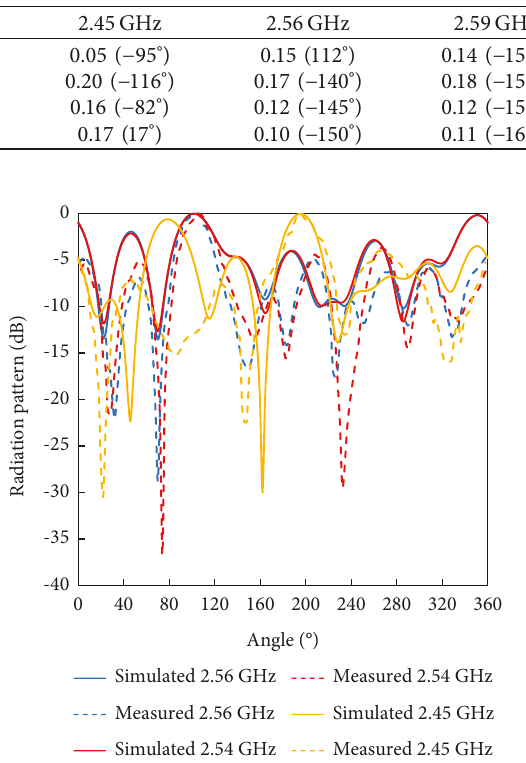
Figure 25: Simulation (solid lines) and measurement (dashed lines) results of the radiation patterns of the dipole antenna array and RF beamformer circuit.